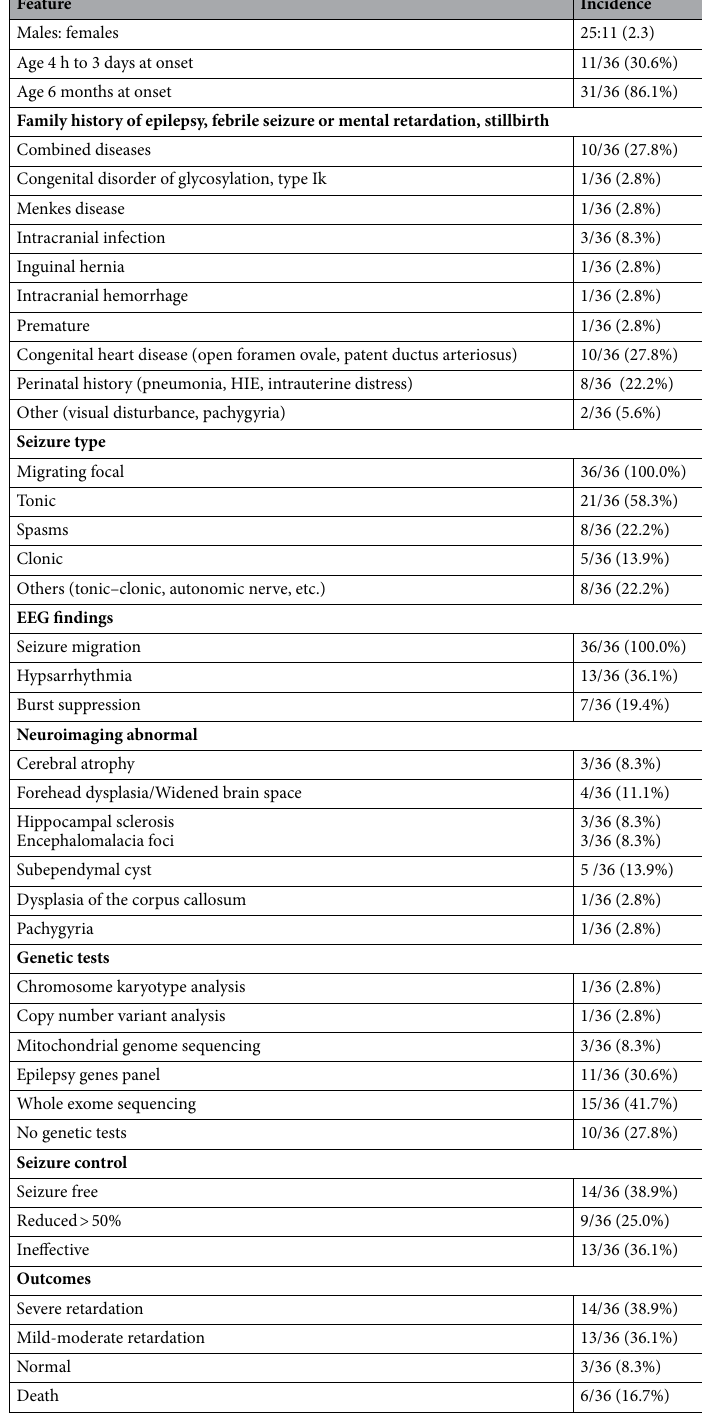
Table 1. Clinical features of the 36 children with MMPSI. HIE, Hypoxic-ischemic encephalopathy; MMPSI, Malignant migrating partial seizures of